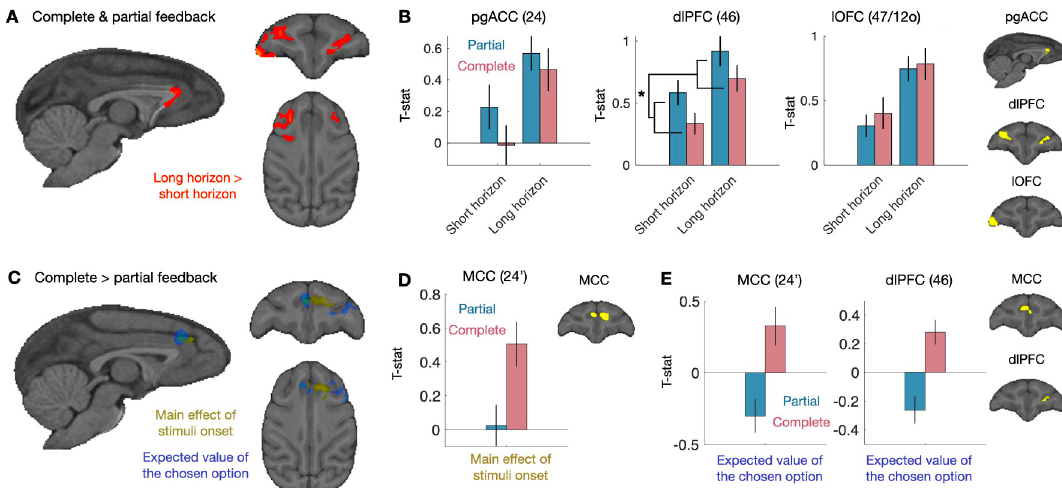
Fig 4. First choice neural results. ( A ) When combining partial and complete feedback sessions, we found clusters for a differential in activity in long horizon than short horizon in the pgACC, the dlPFC, and the lateral OFC. Cluster p < 0.05, cluster forming threshold of z > 2.3. ( B ) We placed ROIs (in yellow) in the overlap of the functional cluster and anatomical region and extracted t-statistics for the difference between long horizon and short horizon. Mean across sessions (partial feedback: 40 sessions, complete feedback 34 sessions). ( C ) We looked for differences in how the contingency between choice and information (complete vs. partial feedback) modulates the initial information that was presented before first choices. Within our VOI, we found clusters of activity in MCC both for the main effect of feedback type and a greater sensitivity to expected value in the complete feedback condition. We also found a cluster of activity in dlPFC for a greater sensitivity to expected value in the complete feedback condition. ( D ) We placed an ROI (in yellow) in the part of MCC that is activated by the main effect of feedback type and extracted the t-statistics of the regressor for every session. We found that the effect we observe in the VOI is driven by increased activity in the complete feedback condition, whereas there is no activity in the partial feedback condition. Mean across sessions (partial feedback: 40 sessions, complete feedback 34 sessions). ( E ) We also placed ROIs (in yellow) in the parts of MCC and dlPFC where we found significant clusters in the VOI for the interaction of feedback type and expected value and extracted the t-statistics for the expected value regressor of every session. Plotting these regressors separately for feedback type reveals that both MCC and dlPFC were more active when an option with high expected value was chosen in the complete feedback condition, whereas they were more active when an option with low expected value was chosen in the partial feedback condition. Mean across sessions (partial feedback: 40 sessions, complete feedback 34 sessions). Error bars represent standard error to the mean. � p < 0.05. Data and code to reproduce the figure can be found at https://doi.org/10.5281/ zenodo.7464572. dlPFC AU : AbbreviationlistshavebeencompiledforthoseusedinFigs 4 and 5 ; attheendofeachfigurecaption : Pleaseverifythatallentriesarecorrect : , dorsolateral prefrontal cortex; MCC, anterior and mid-cingulate cortex; OFC, orbitofrontal cortex; pgACC, pregenual anterior cingulate cortex; ROI, region of interest; VOI, volume of